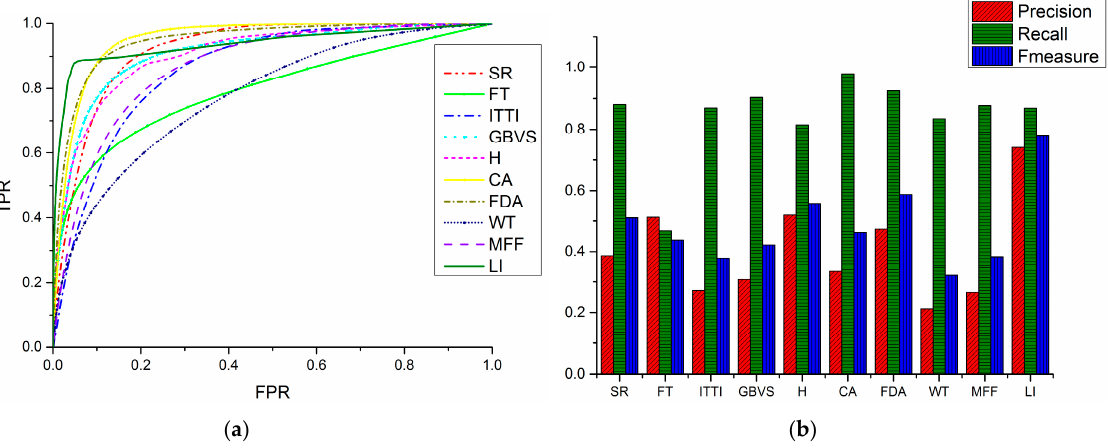
Figure 15. Quantitative comparisons for images polluted by Gaussian noise (Standard Variance = 0.05): ( a ) ROC curves; and ( b ) PRF values.